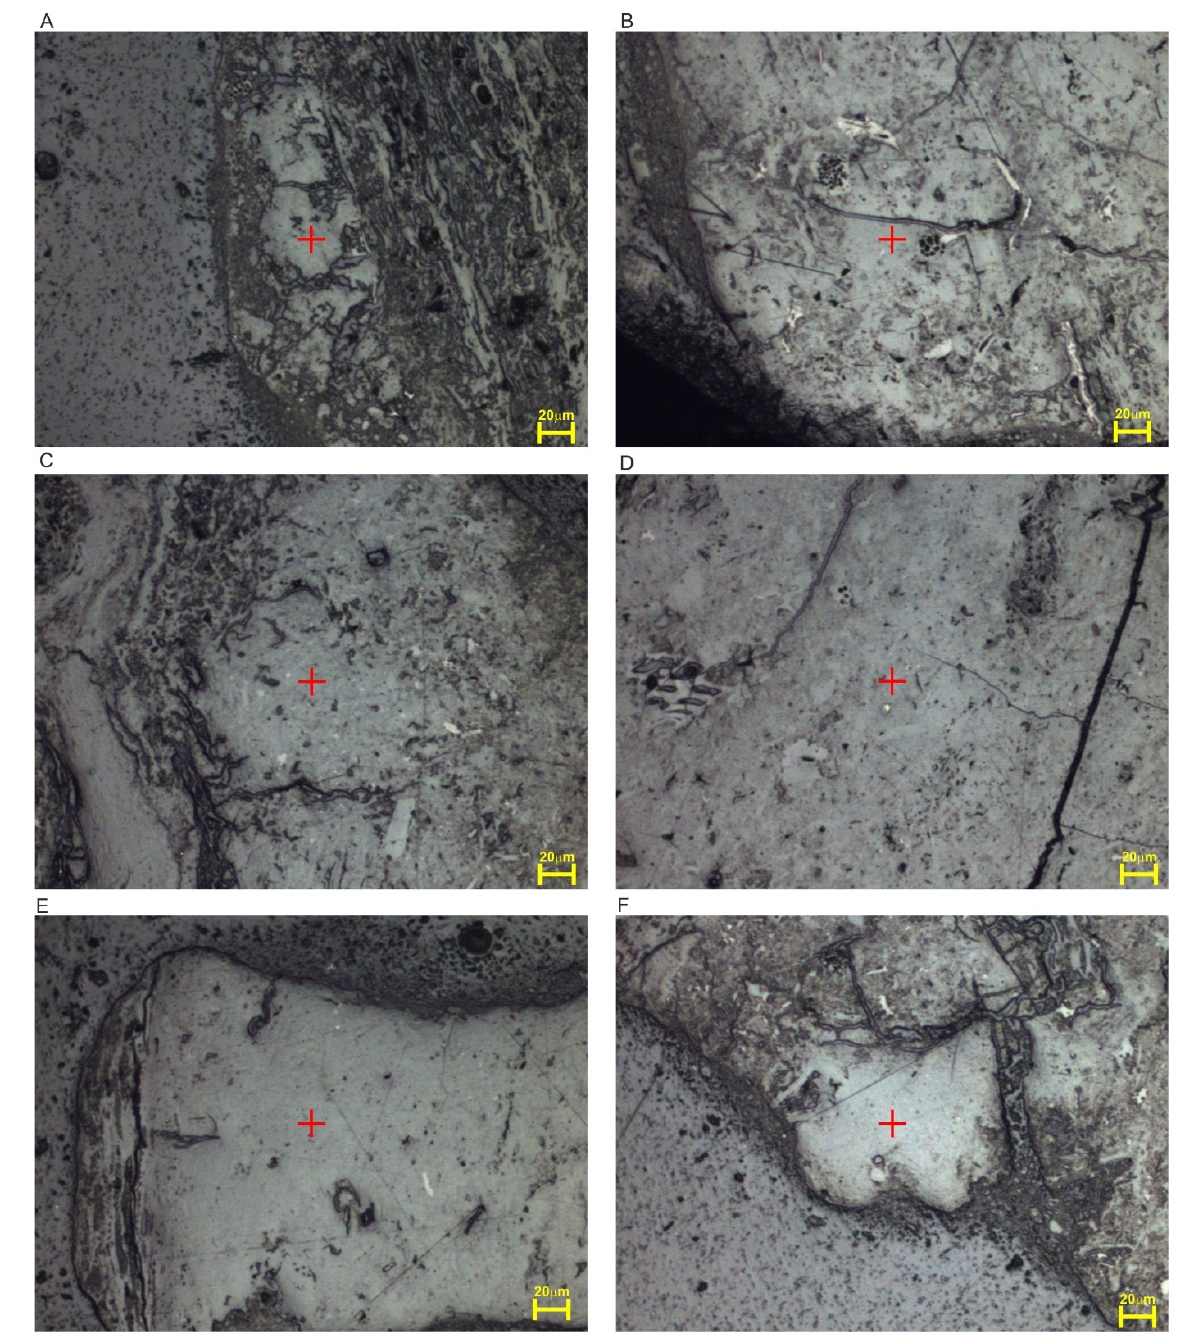
Figure A2. Selected measurement points (+) on densinite ( A – F ).